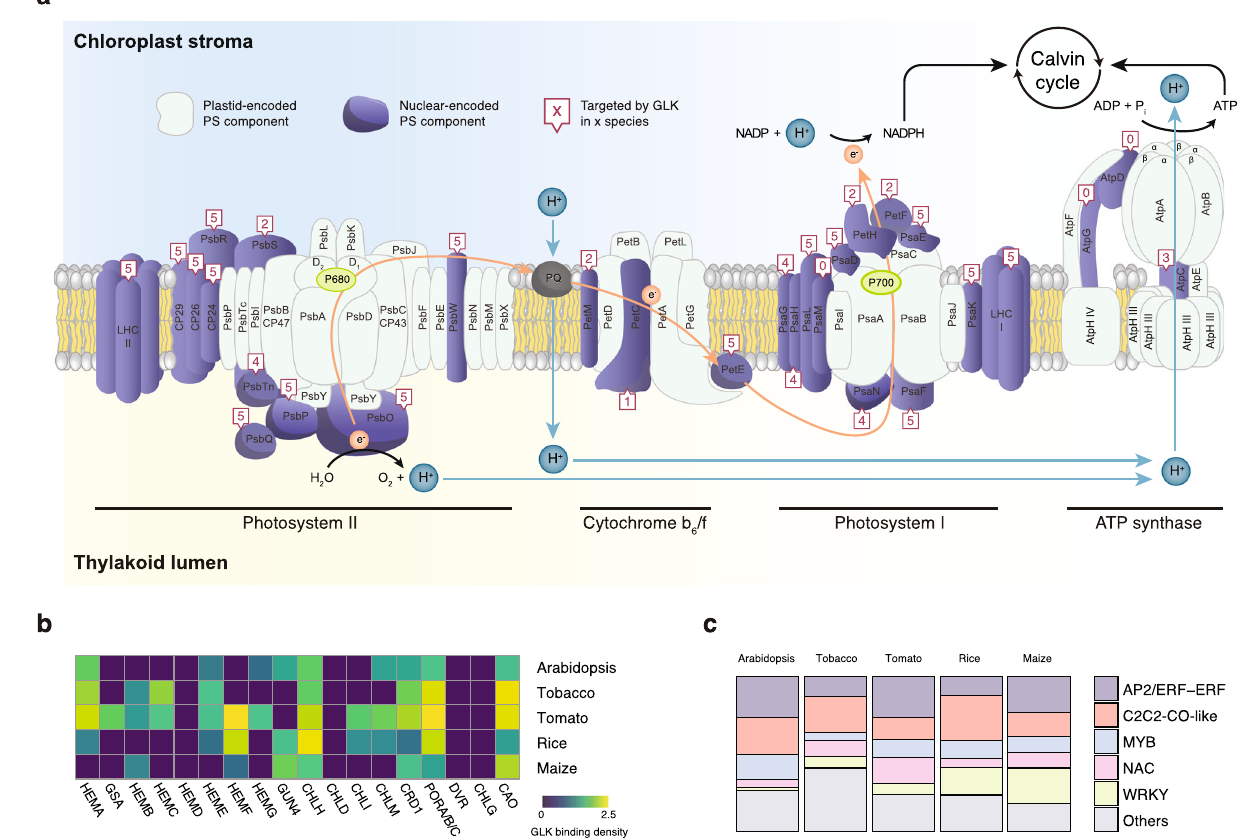
b Heatmap showing genes in the chlorophyll biosynthesis pathway and their GLK ChIP-seq signal ( − log(foldchange)). c Bar chart showing the percentage of con- served TF genes bound by GLK. Source data are provided as a Source Data fi